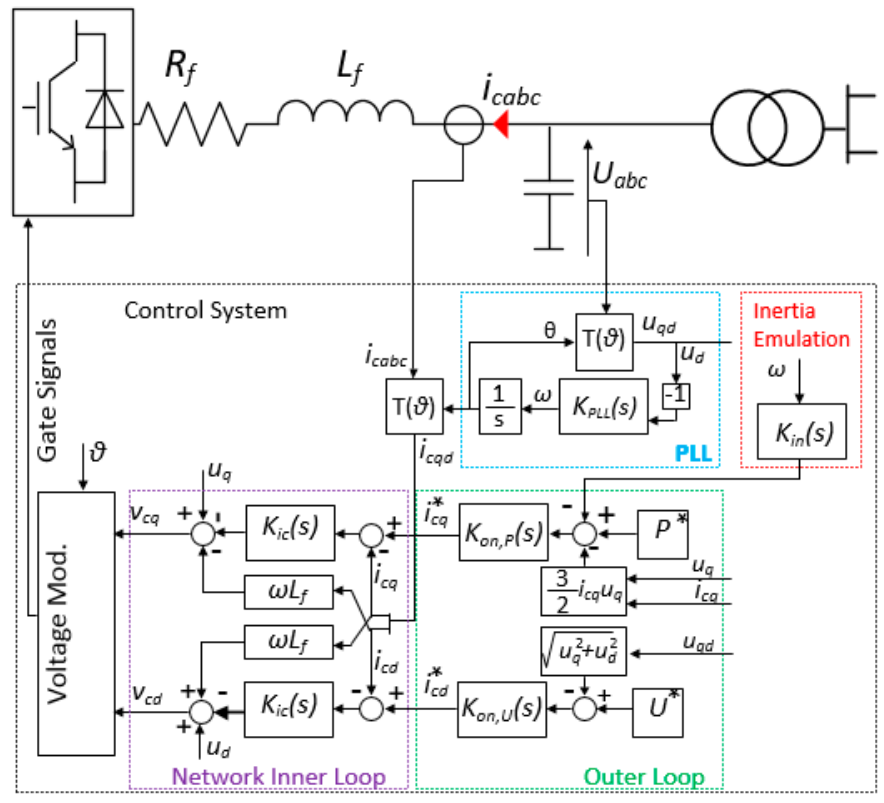
Figure 4. Power voltage current control with inertia emulation controller diagram.